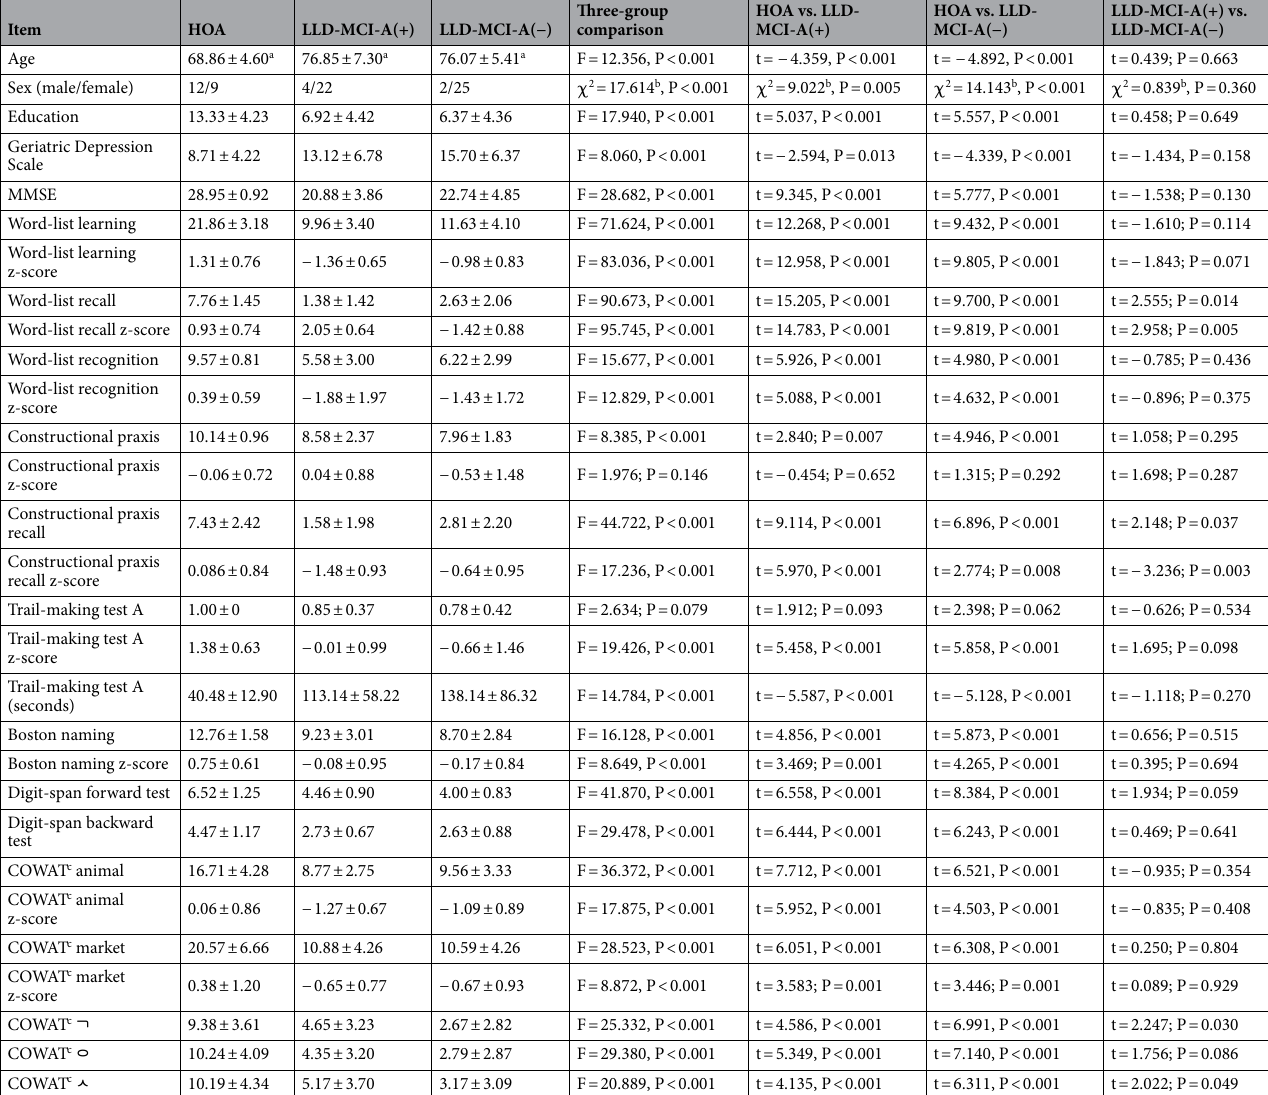
Table 1. Demographic information. a Mean ± standard deviation. b Yates’ χ 2 . c COWAT controlled oral word association